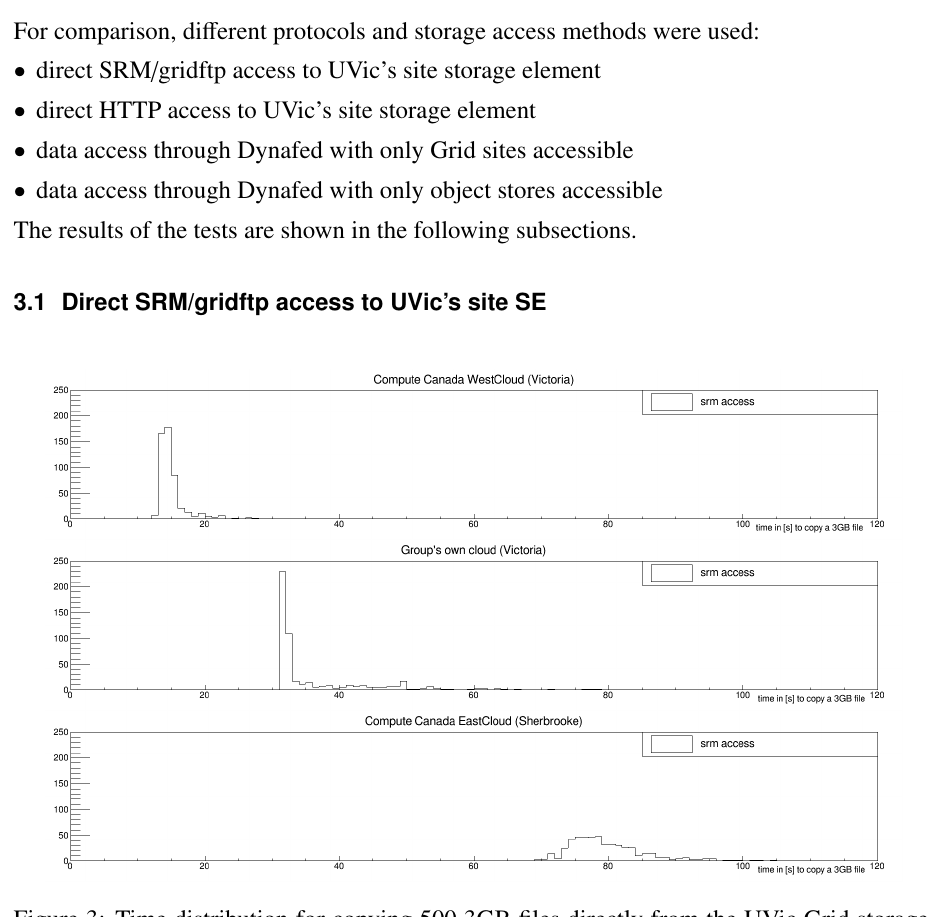
Figure 3: Time distribution for copying 500 3GB files directly from the UVic Grid storage, initiated by clients on di ff erent clouds using the SRM / gridftp